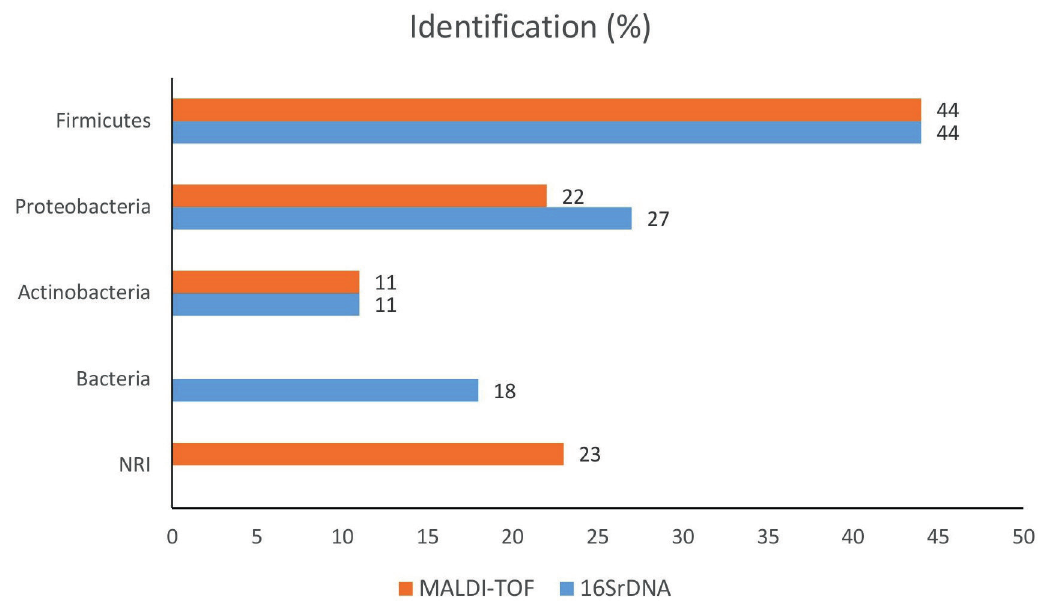
Figure 2 - Comparison of the bacteria identification methods 16S rRNA and MALDI-TOF